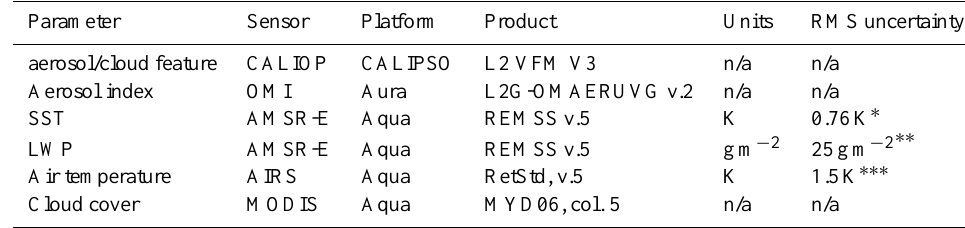
Table 1. Data sources. Parameter Sensor Platform Product Units RMS uncertainty aerosol/cloud feature CALIOP CALIPSO L2 VFM V3 n/a n/a Aerosol index OMI Aura L2G-OMAERUVG v.2 n/a n/a SST AMSR-E Aqua REMSS v.5 AMSR-E Aqua REMSS v.5 AIRS Aqua Cloud cover MODIS Aqua MYD06, col. 5 n/a n/a